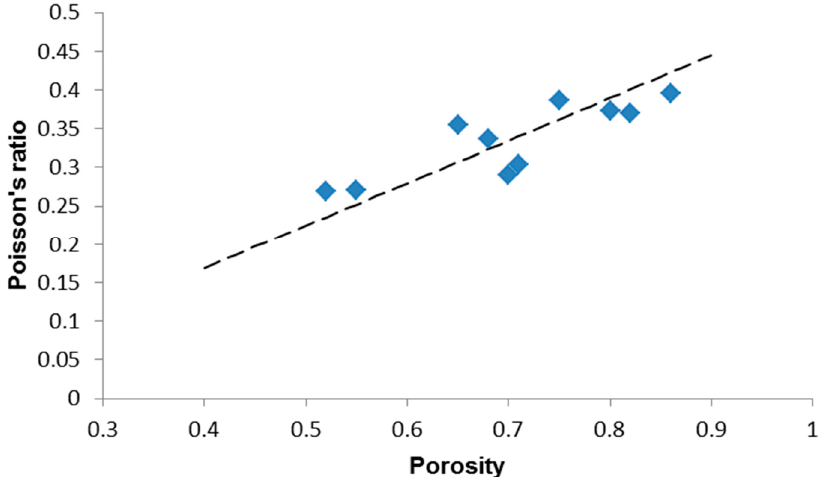
Figure 5. Porosity dependence of the Poisson’s ratio in highly porous 45S5 glass-derived foams with data interpolation by a linear model (Equation (9)).